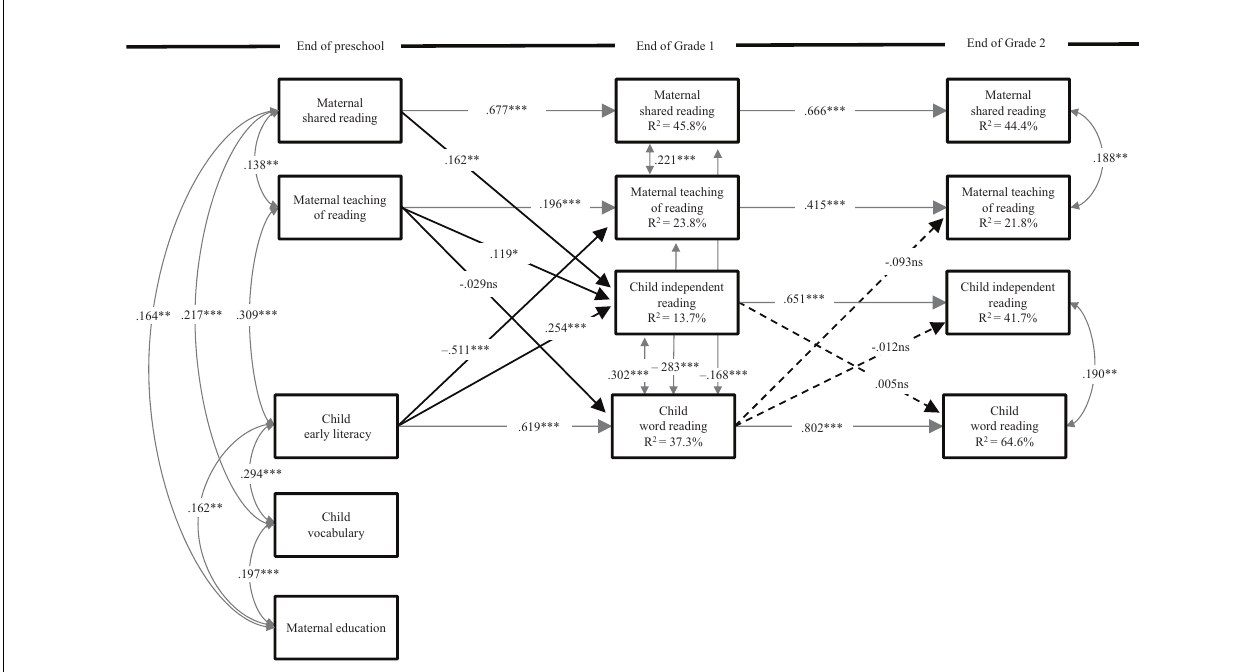
FIGURE 2 | Standardized parameter estimates of the hypothesized model. Gray paths indicate correlations and auto-regressors; black solid paths are statistically significant; and black dashed paths are not. ∗ p < 0.05, ∗∗ p < 0.01, ∗∗∗ p <